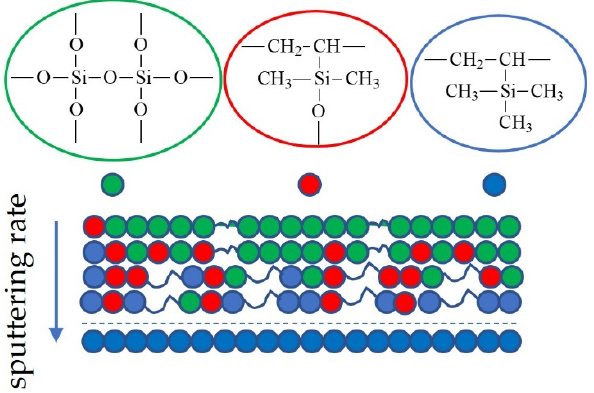
Figure 7. Schematic view of the proposed structure of the modified subsurface layer.